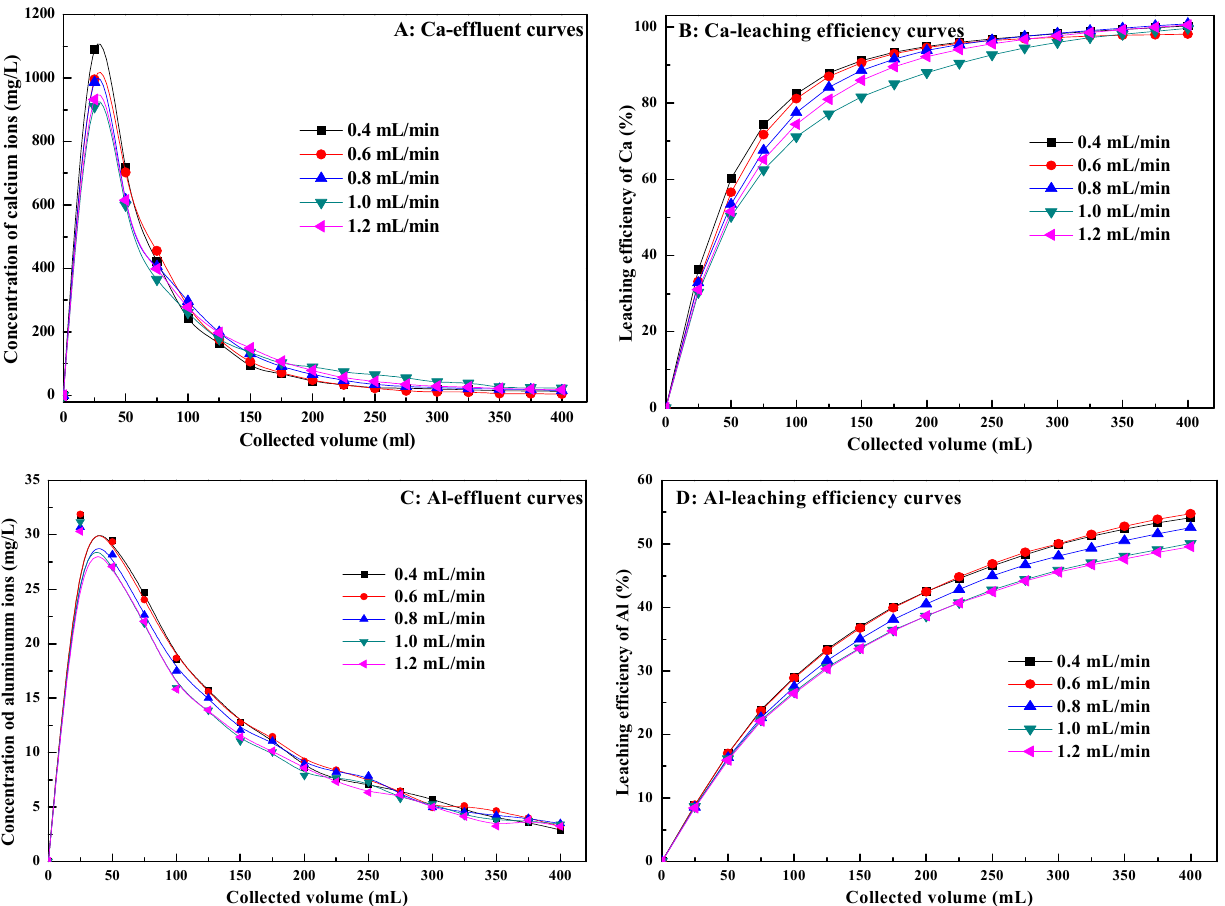
Figure 12. Column leaching behaviors of calcium and aluminum with different flow rates of the leaching agent (T = 20 °C, C 0 = 0.20 mol/L, pH = 5.70). ( A) Ca-effluent curves, ( B) Ca-leaching efficiency curves, ( C ) Al-effluent curves, ( D) Al-leaching efficiency curves)